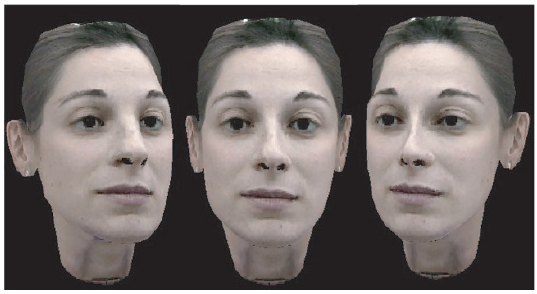
Figure 8: The generated head model, viewed from three di ff erent